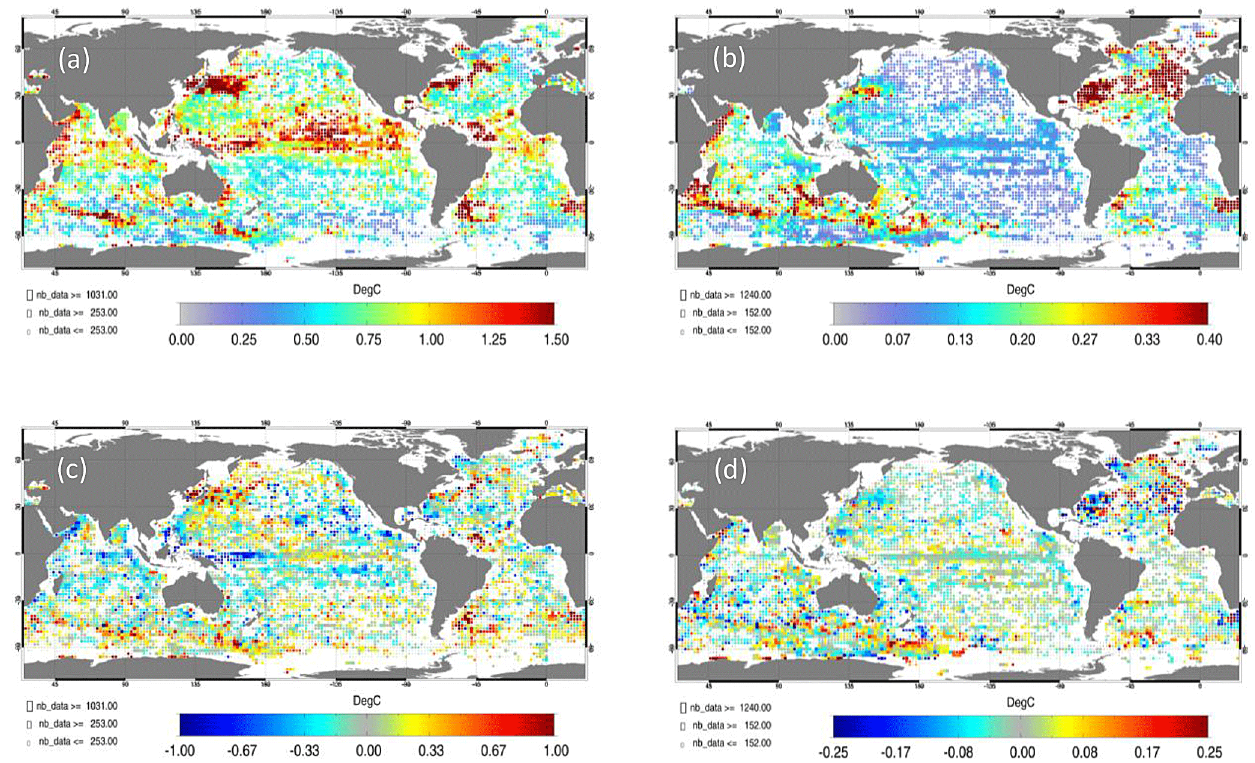
Figure 3. Spatial distribution of the RMS and the mean temperature differences between Run-NoArgo and Argo observations in the 0–300 and 700–2000m layers over the last 6 months of the experiments. (a) shows the RMS temperature differences in the 0–300m layer. (b) shows the RMS temperature differences in the 700–2000m layer. (c) shows the mean temperature differences in the 0–300m layer. (d) shows the mean temperature differences in the 700–2000m layer. The size of the colored boxes is proportional to the number of observations falling into that 2 ◦ × 2 ◦